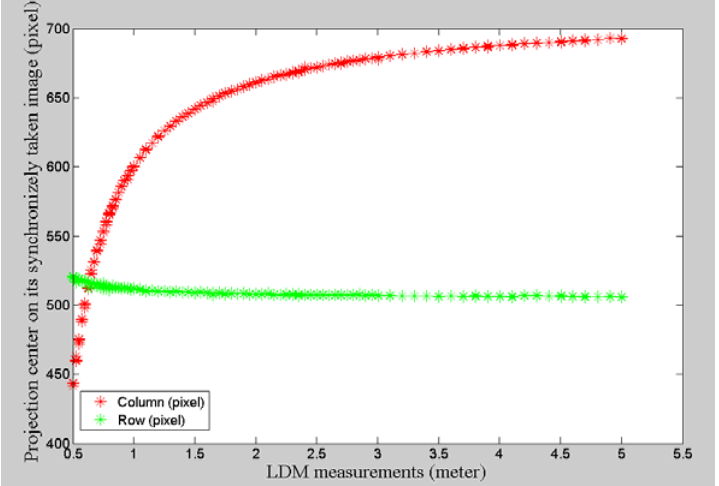
Figure 6. The image position of the projection center with varying laser distance